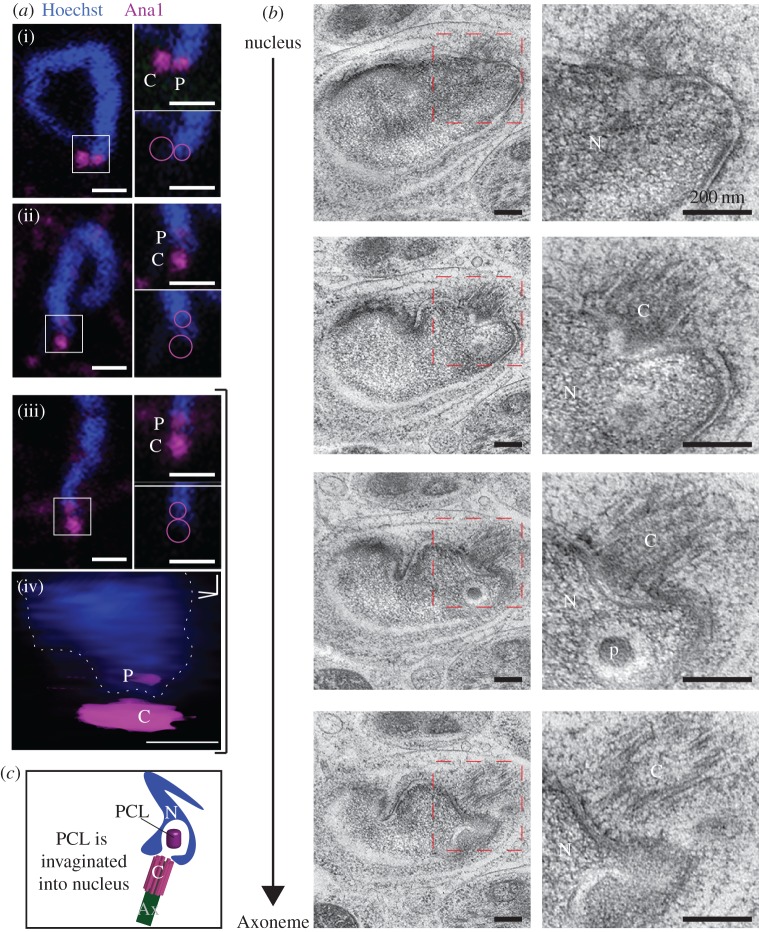
The 2nd Ana-1 labelled centriole is the PCL. (a) Single 0.3 µm thick confocal sections showing that the proximal Ana1 dot is located inside the nucleus boundary in golfclub/S-shaped spermatid stage (i–iii). Circles mark the location of the centriole and PCL in the inset. Three-dimensional volume model of the PCL in an S-shaped spermatid iii (iv). Scale bars, 1 µm. (b) Serial section TEM analysis showing that only the PCL is found in the cytosolic invagination within the nucleus at the golfclub/S-shape spermatid stage. Scale bars, 200 nm. (c) A schematic diagram showing the location of the PCL in a cytosolic invagination within the nucleus. Abbreviations: Ax, axoneme; C, centriole; N, nucleus; P, PCL.